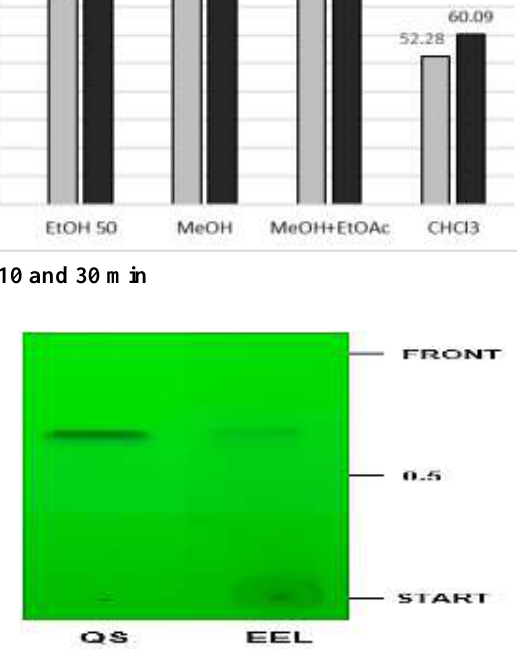
Figure 8. TLC plate of quercetin and ethanolic